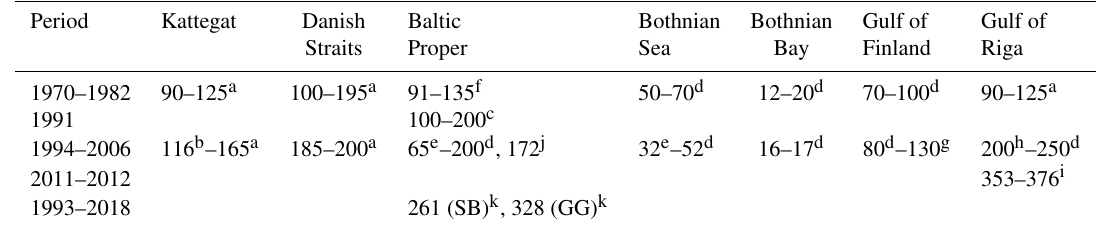
Table 2. Annual primary production (gCm − 2 yr − 1 ) in different areas of the Baltic Sea. Updated from Savchuk et al. (2012c). Period Kattegat Danish Baltic Bothnian Bothnian Proper